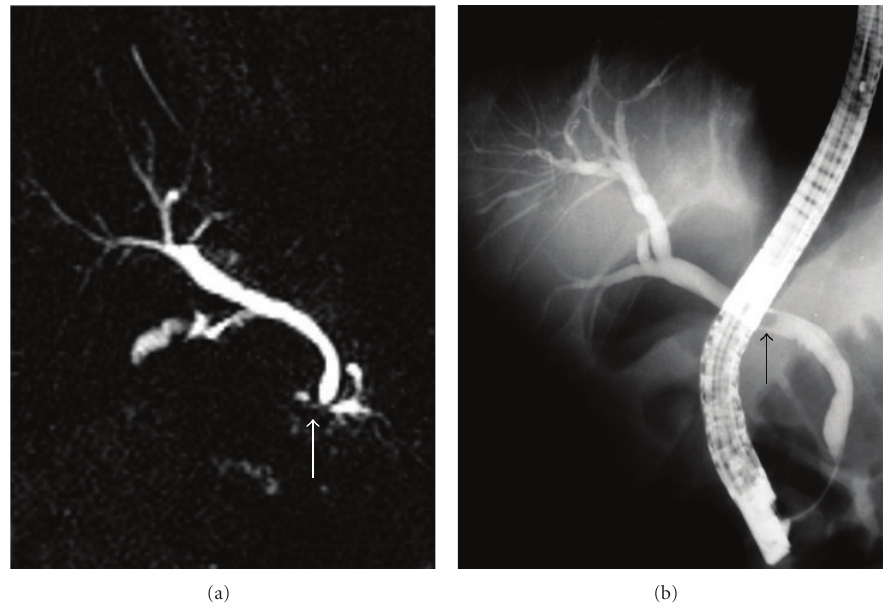
Figure 2: MRCP image demonstrates (a) a calculus (white arrow) located in the distal common bile that does not cause bile duct dilatation. This calculus was not detected during the MRI examination and received a false negative diagnosis. (b) ERCP image demonstrates the calculus (black arrow). This calculus was extracted during the